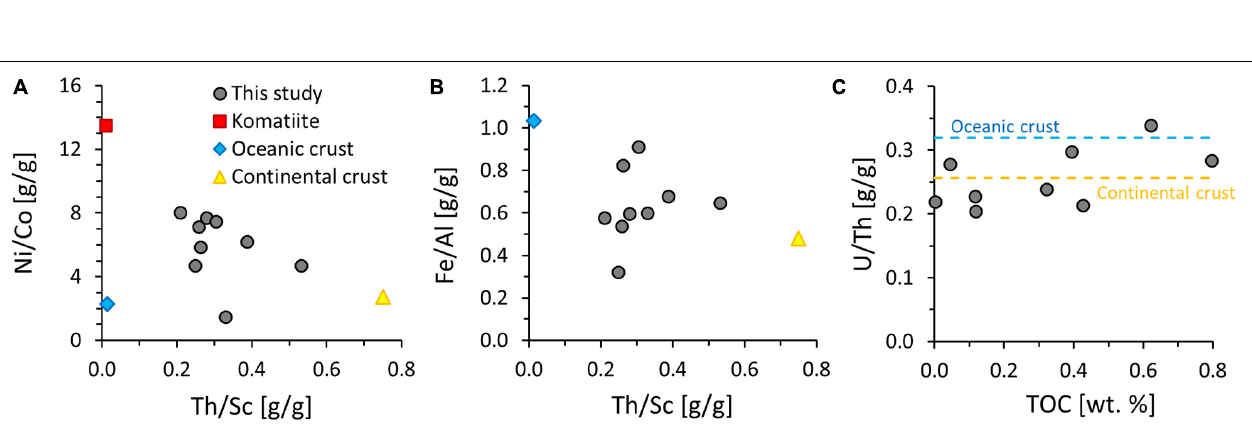
FIGURE 5 | Geochemical provenance and redox indicators. (A) Ni/Co vs. Th/Sc. (B) Fe/Al vs. Th/Sc. (C) U/Th vs. total organic carbon (TOC). Reference values for average crust and komatiite are taken from the literature (Rudnick and Gao, 2014; White and Klein, 2014; Ptáˇcek et al., 2020).